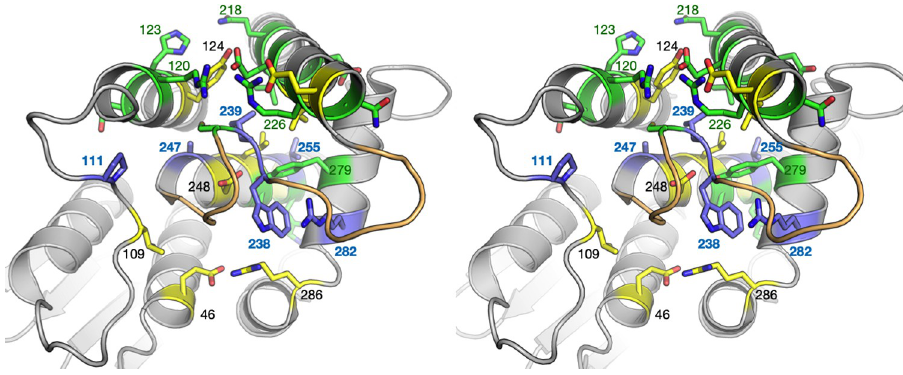
Fig 9. An overview of the α 6- α 7 loop and its surroundings in light of known CMT mutations and conserved positions. In this stereo view, the α 6- α 7 loop is coloured orange, green shows positions for CMT mutations, yellow positions that are highly conserved, and blue the positions that are both targeted by CMT mutations and highly conserved. Selected residues are labelled for clarity.